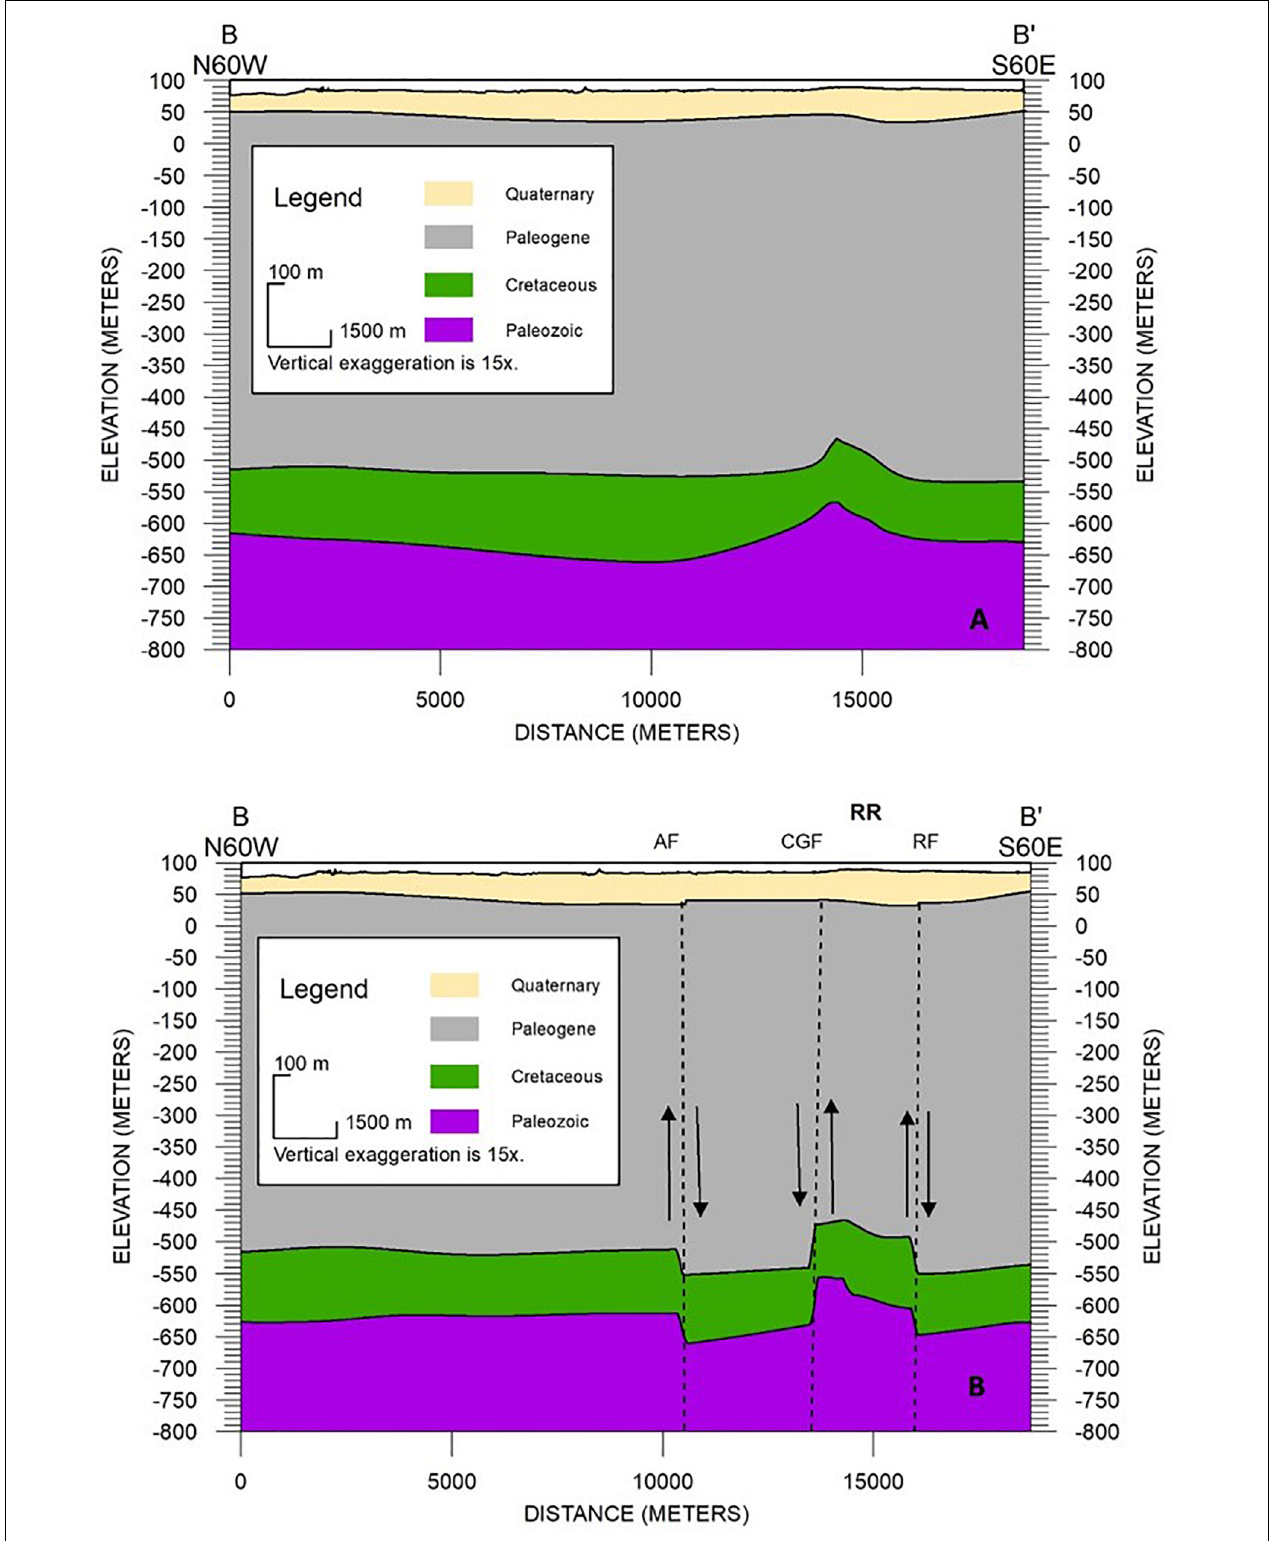
FIGURE 9 | (A) Cross-Section B-B’ (unfaulted) as located in Figure 3 shows the Quaternary alluvium (peach), Eocene (gray), Cretaceous (green), and Paleozoic (purple). (B) Faulted Cross-Section B-B”. RR, Ridgely ridge; AF, Axial fault; CGF, Cottonwood Grove fault; RF, Ridgely fault. Vertical exaggeration = 15.